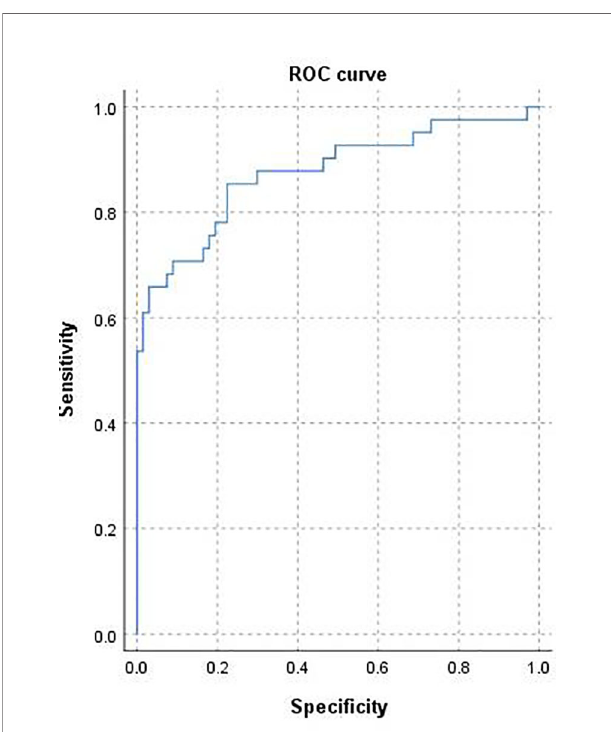
FIGURE 3 | Receiver operating characteristic curve for the prediction model. Area under the curve was 0.875 (95% con fi dence interval 0.80 – 0.95).